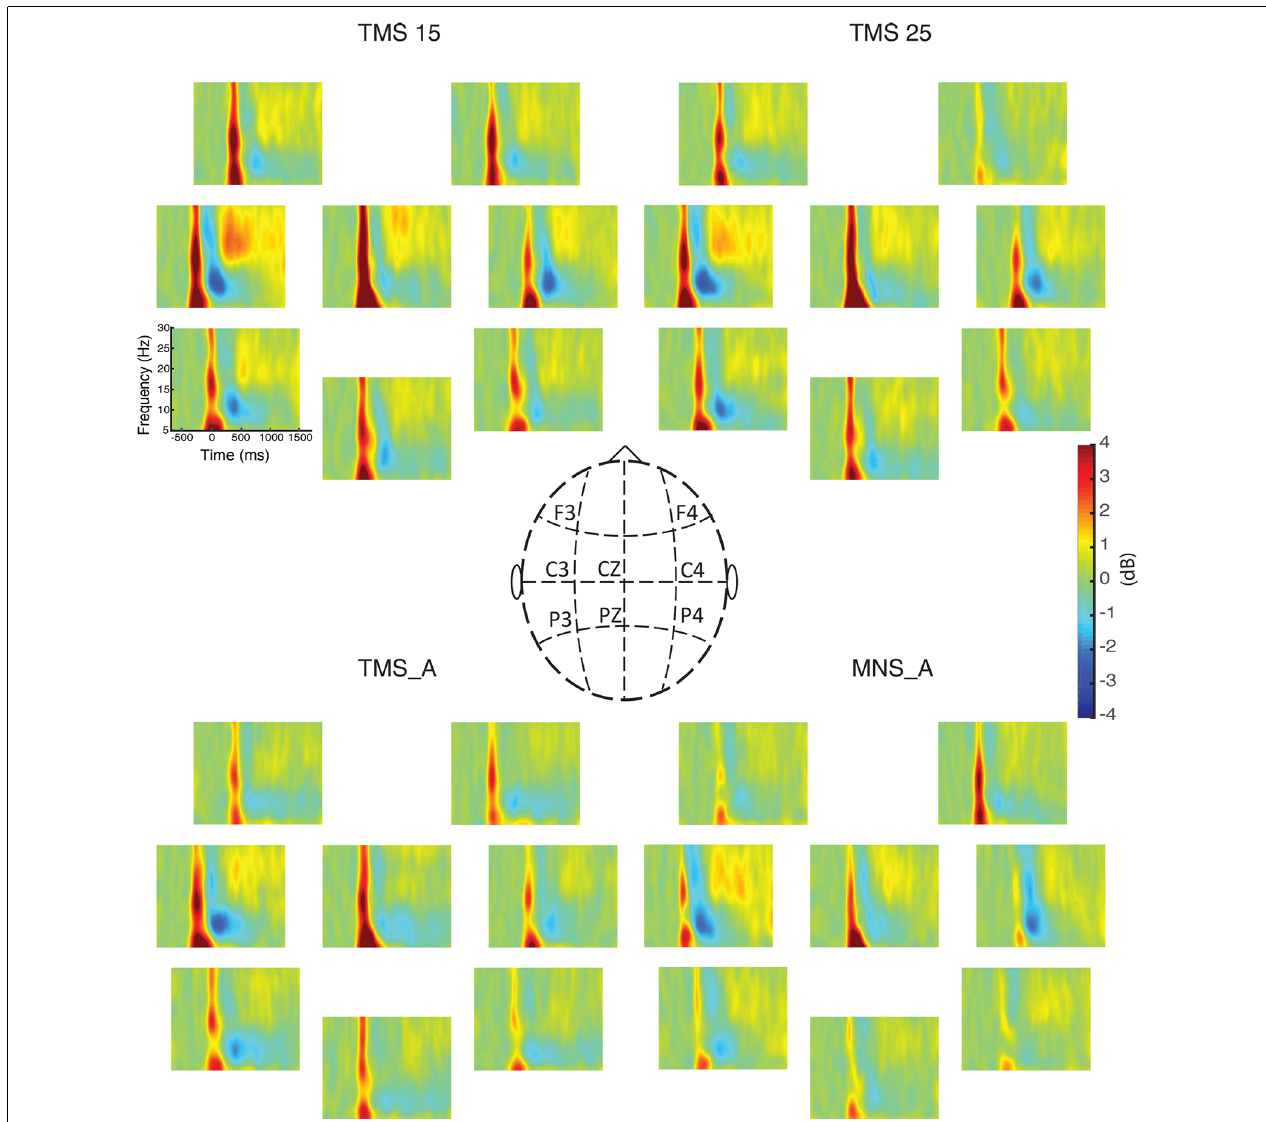
FIGURE 3 | Event-related spectral perturbations (ERSPs) for all electrodes. The power spectra between 5 and 30 Hz are shown for all experimental conditions (upper left: MNS + TMS15, upper right: MNS + TMS25, lower left: TMS_A, and lower right: MNS_A). Electrode positions on the scalp are illustrated in the middle